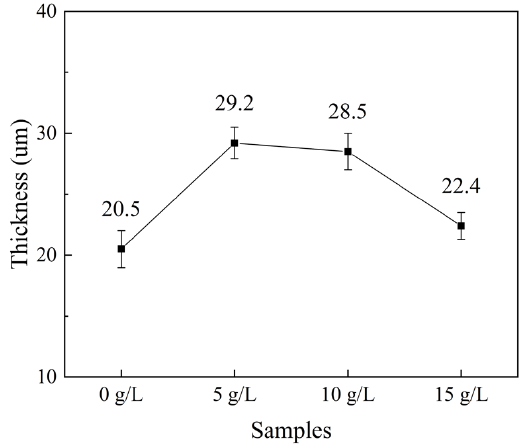
Figure 4. The thickness of MAO coatings with different CuSO 4